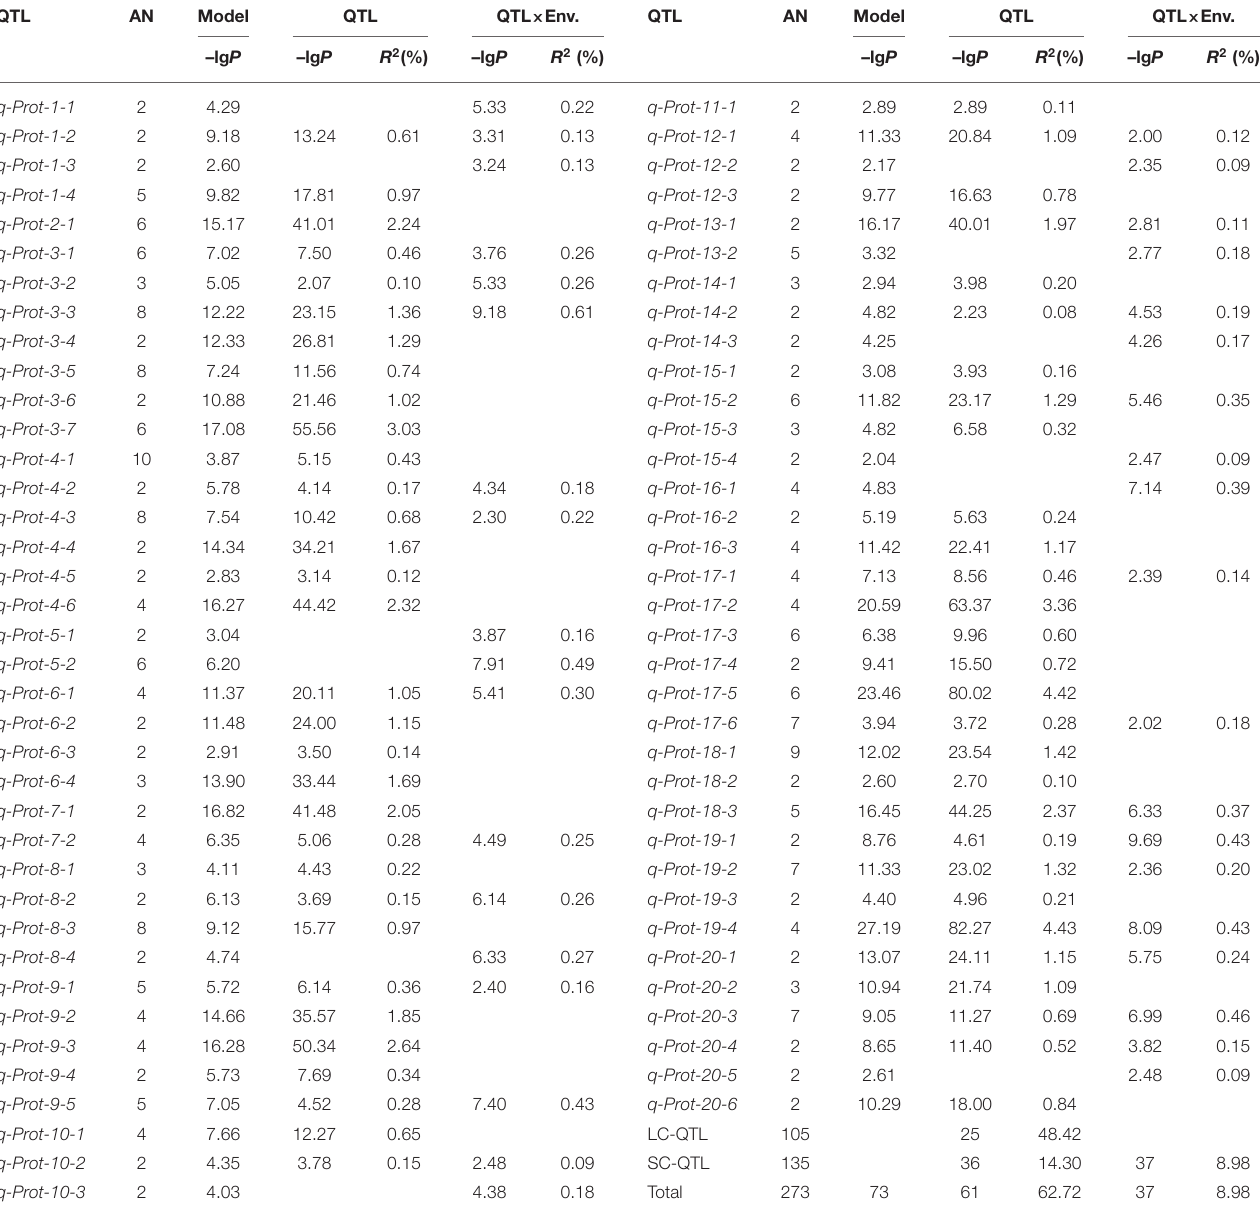
TABLE 2 | QTLs/SNPLDBs associated with SPC in the